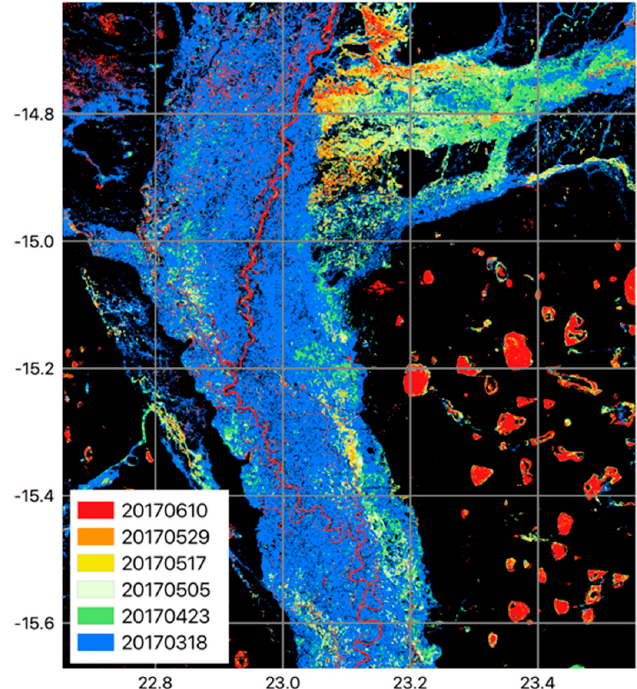
Figure 14. Sequential images representing the 2017 draw-down of water following the peak of the wet season (mid-March) to the start of the dry season (June). Colour represents the latest date on which water was present.